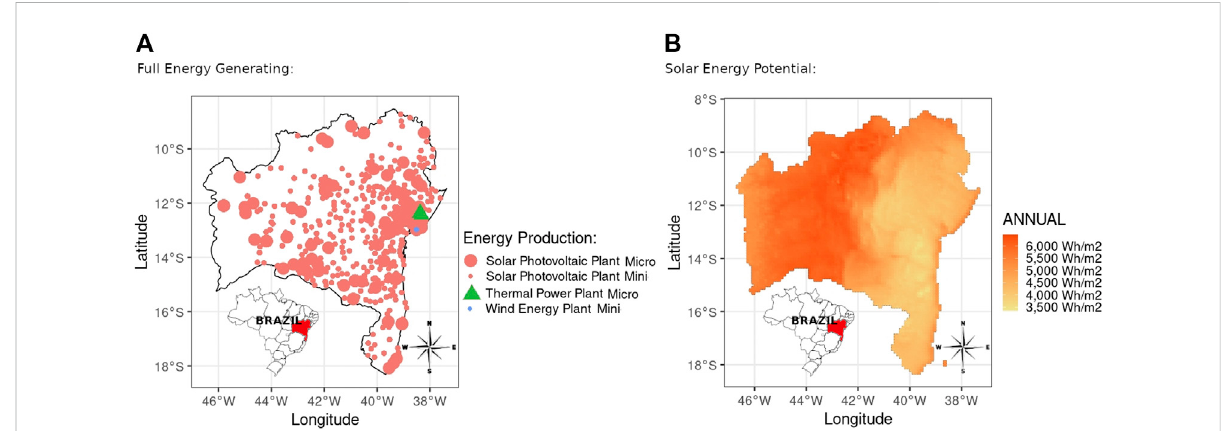
FIGURE 2 Representation of the type of energy generation in the State of Bahia by installed projects.